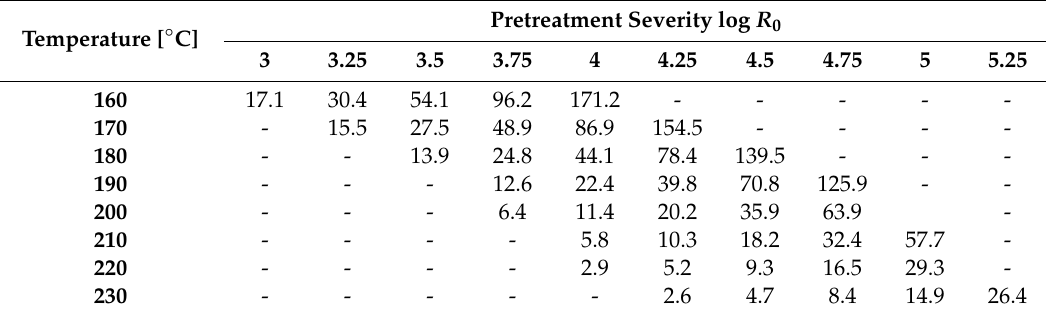
Table 1. Summary of the tested pretreatment conditions. Shown are the pretreatment durations in [min] to reach the targeted severities log R 0 (see Equation (1)) at a given temperature. Temperature [ ◦